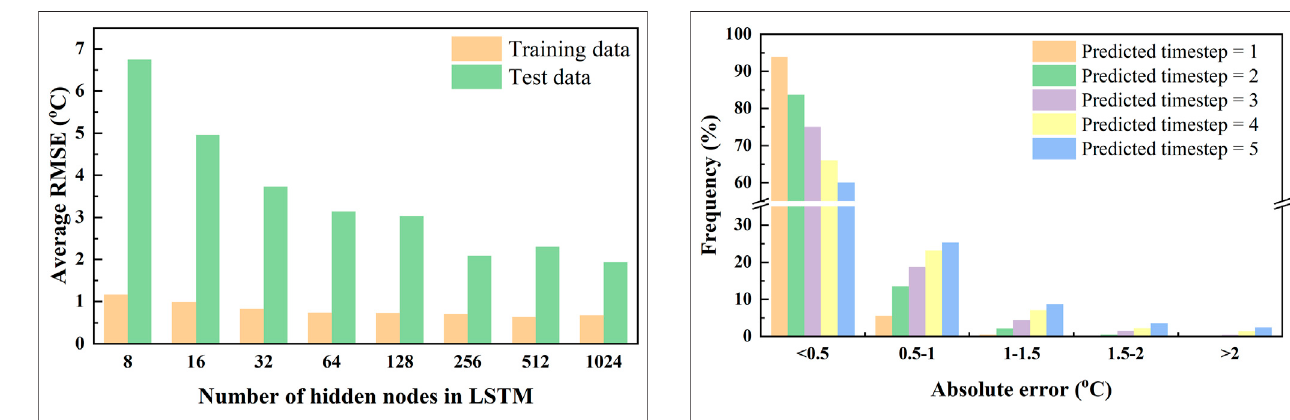
FIGURE 6 | Average RMSEs with different number of hidden nodes.